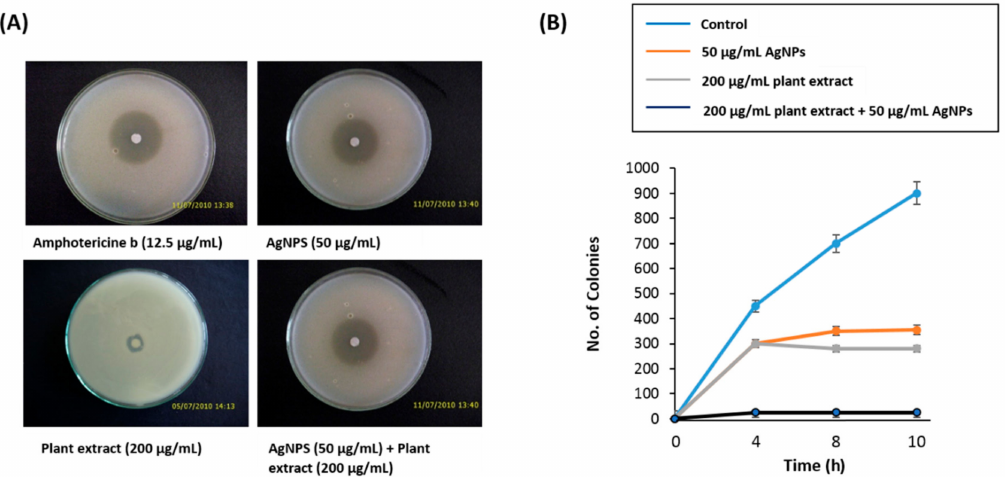
Figure 4. Antimicrobial potential of AgNPs. ( A ) Disc di ff usion method showing the anti-candidal activity of AgNPs and the synergistic anti-candidal potential of AgNPs (50 µ g / mL) mixed with C. gigantea leaf extract (200 µ g / mL). Data are expressed as the mean zone of inhibition in mm. ( B ) Time-kill curves of C. albicans following exposure to AgNPs, plant extract, and AgNPs / CG. Non-treated Candida